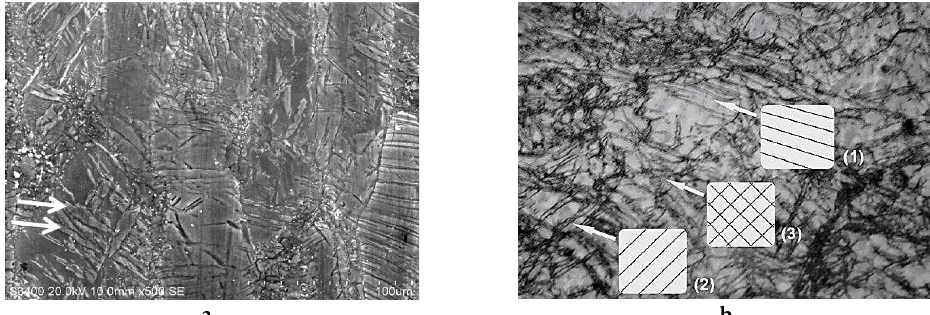
Figure 14. Microstructure and twinning: ( a ): ZK60 for 1 pass A mode at 150 ◦ C: various fields of twins affecting large and well oriented grains, ( b ): AZ31 for 2 passes B C mode at 150 ◦ C where zones can be seen as twin orientations along the 2 successive passes directions of (1) and (2) and (3) perpendicular bi-twinned grains.